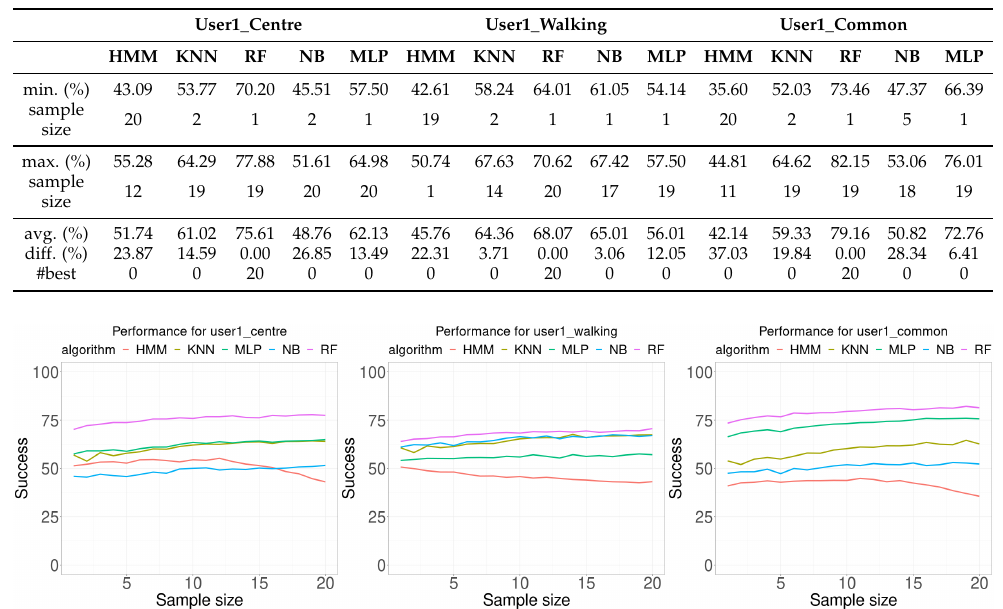
Table 3. Summary of the data shown in Figure 7. The rows for minimum (min.), maximum (max.), average (avg.), and difference (diff.) are given in percentages of successful classification experiments. The row labeled as size is for the corresponding sample size. The row labeled as #best is for the number of times the corresponding algorithm provided the best results.